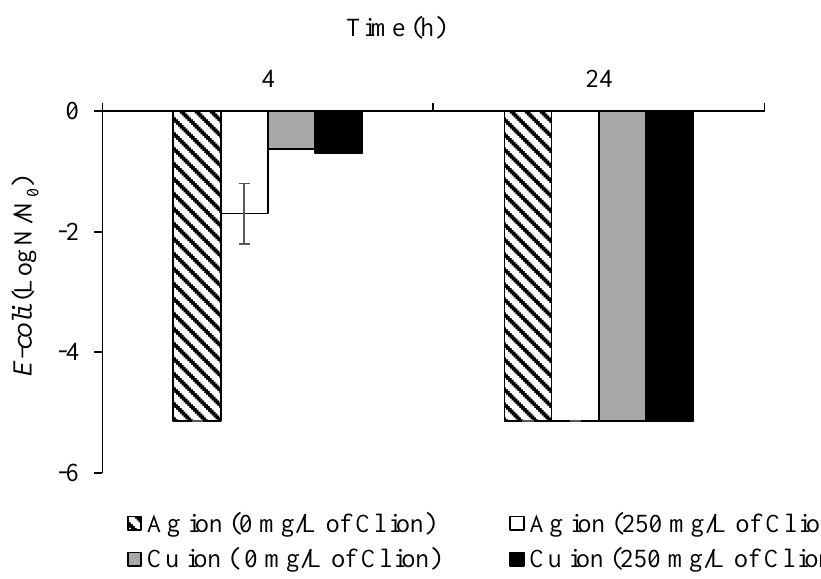
Figure 2. Comparison of E. coli reduction in the presence of chloride ion (250 mg/L) with silver ions (50 ppb) and copper ions (500 ppb).